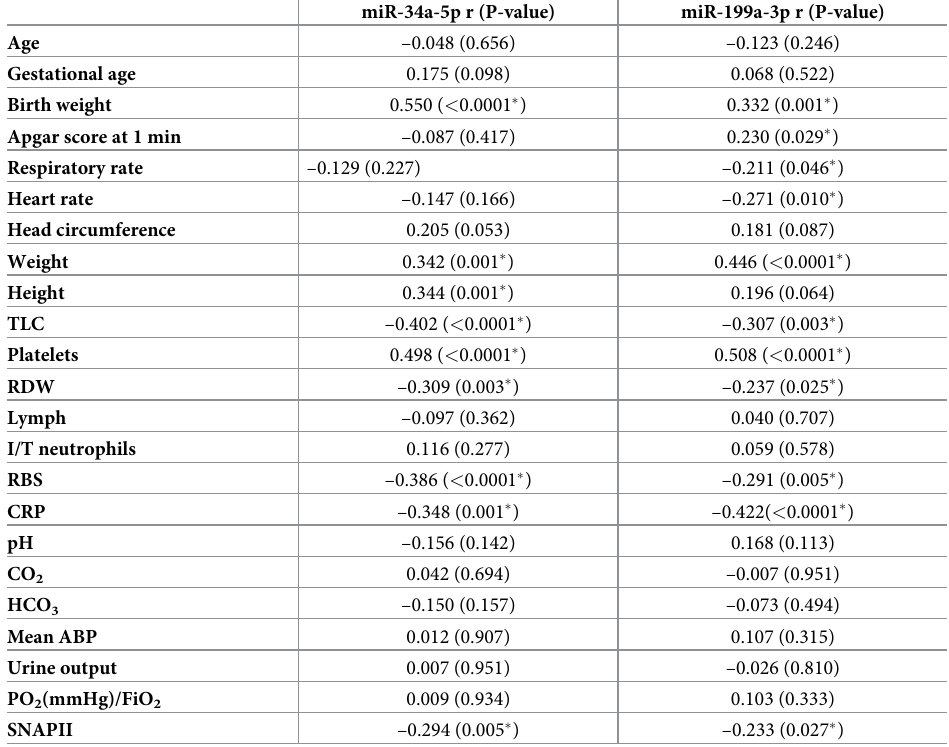
Table 4. Correlations of serum levels of miR-34a-5p and miR-199a-3p with clinical and laboratory data in neo- nates with